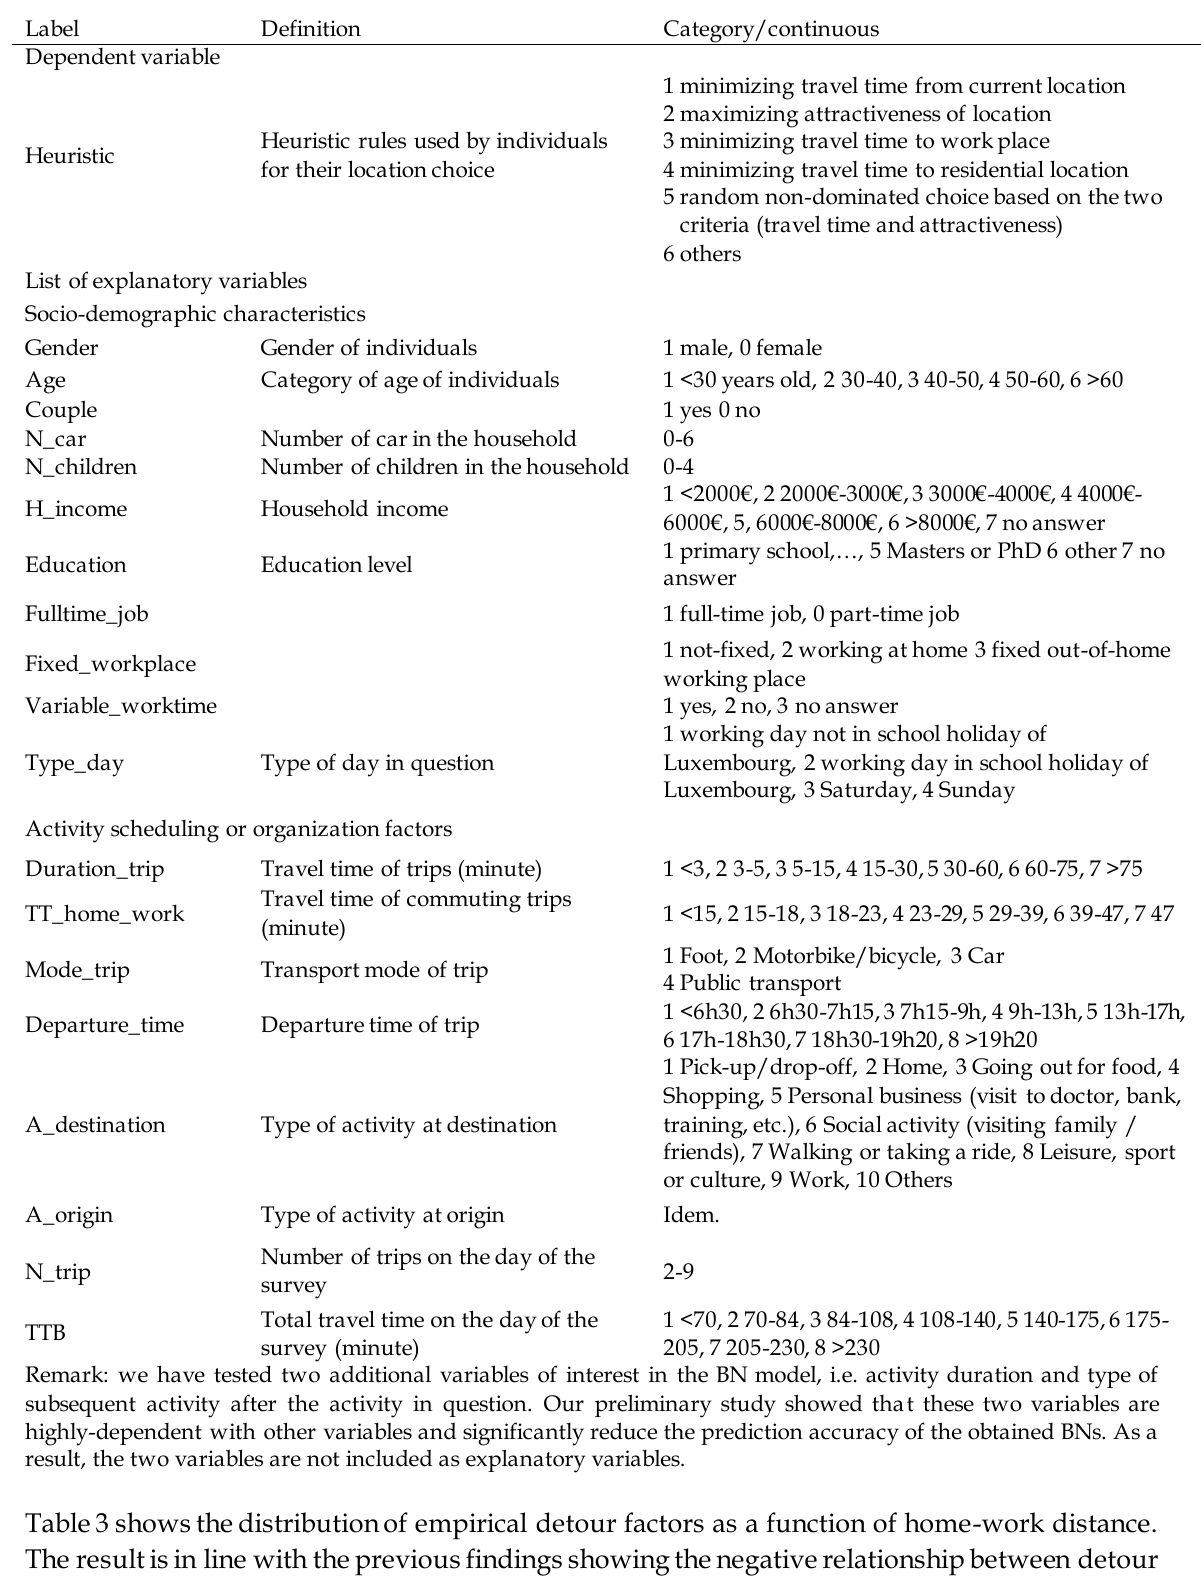
Table 2. List of the dependent and explanatory variables for activity destination